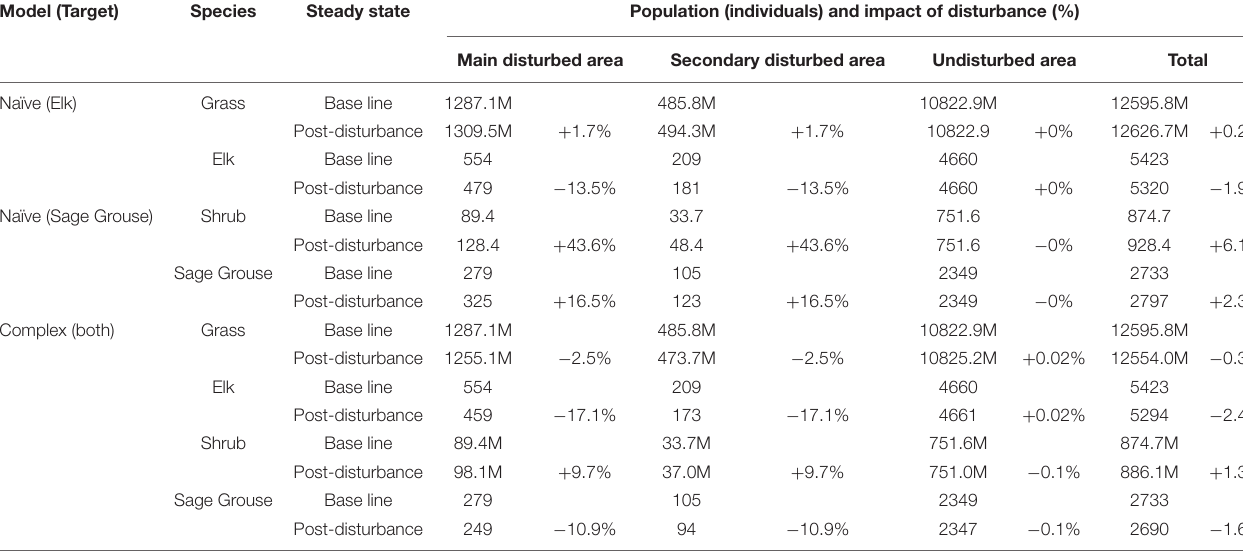
TABLE 1 | Impact of disturbances on the species populations.